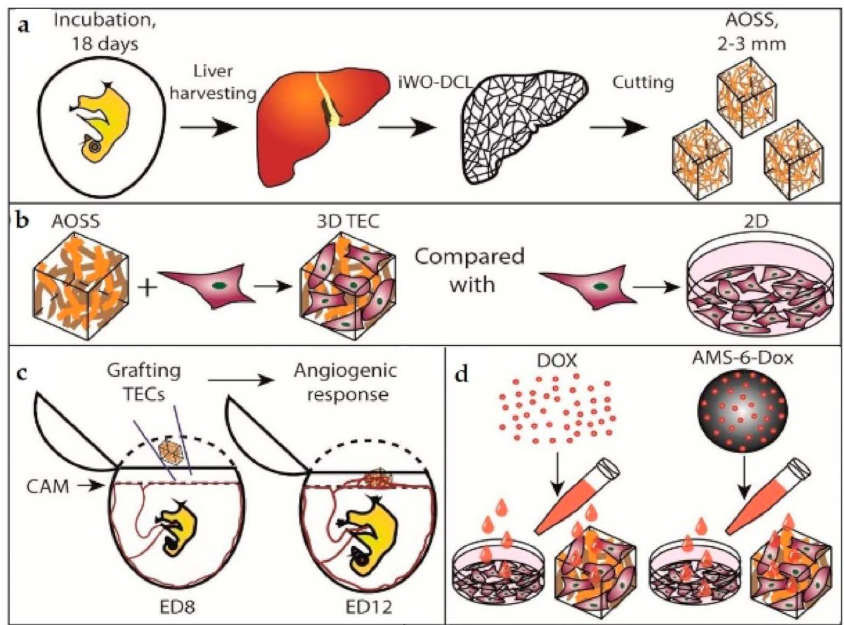
Figure A1. A scheme of the study design. ( a ) Obtaining the liver AOSSs: Incubation of CEs and harvesting livers from ED18 CEs, followed by iWO-DCL of the livers and preparation of the AOSSs by cutting decellularized livers into small fragments. ( b ) Preparation of 3D TECs by seeding of the liver AOSSs with MDA-MB-231 cells; analysis of the colonization patterns and cellular geometries in TECs and comparison of cell population dynamics in TECs with conventional 2D cell cultures by MTT assay and histopathological examination. ( c ) Evaluation of angiogenesis potential of the TECs using CAM assay. ( d ) Comparison of the effect of molecular Dox and nanoparticle-formulated AMS-6-Dox in a 2D culture of TNBC cells and in 3D TECs. Abbreviations: AOSS—acellular organ-specific